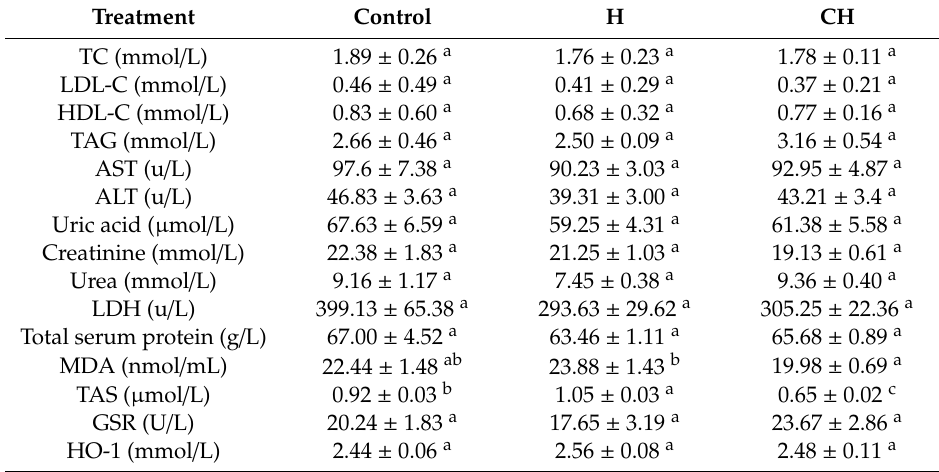
Table 5. Blood parameters of